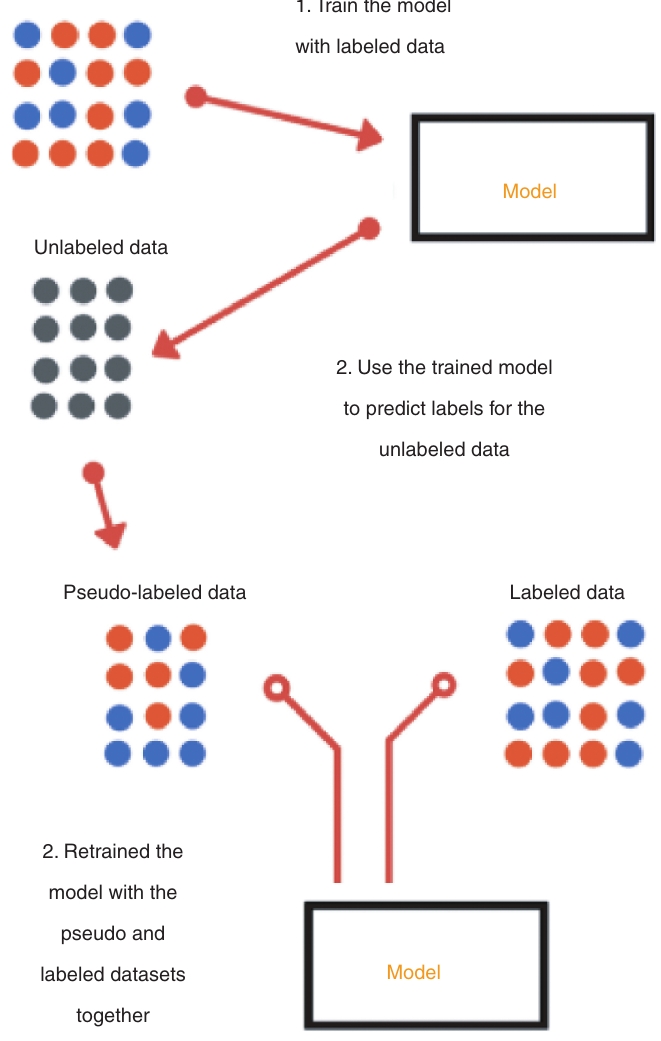
Figure 4: Pseudolabeled